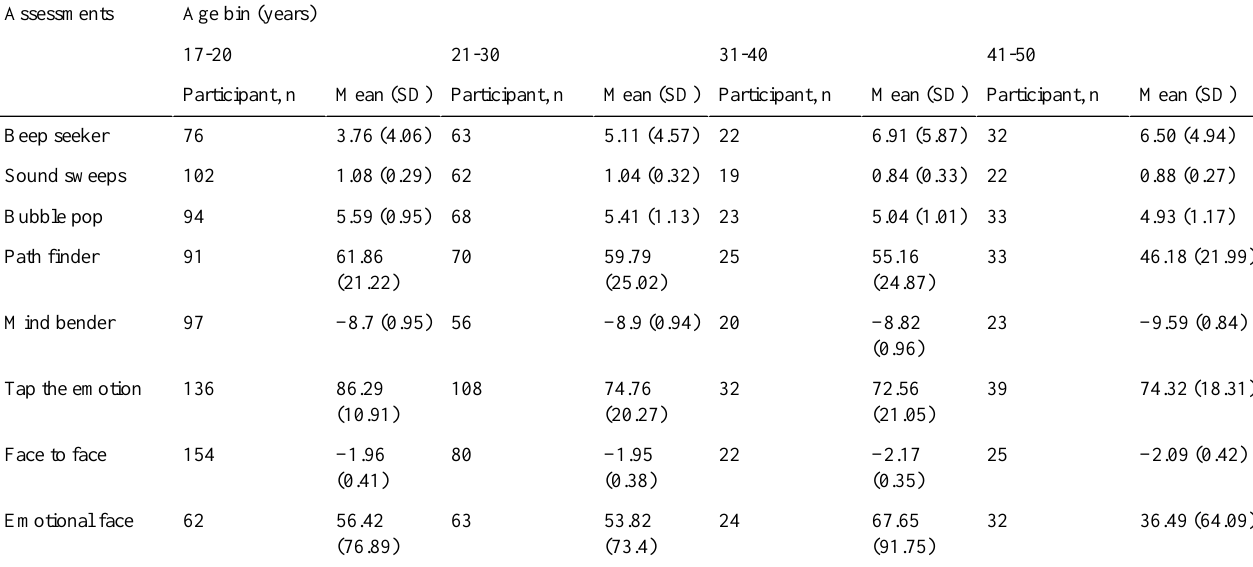
Table 5. Normative data by age bin for ages 17-50 years.